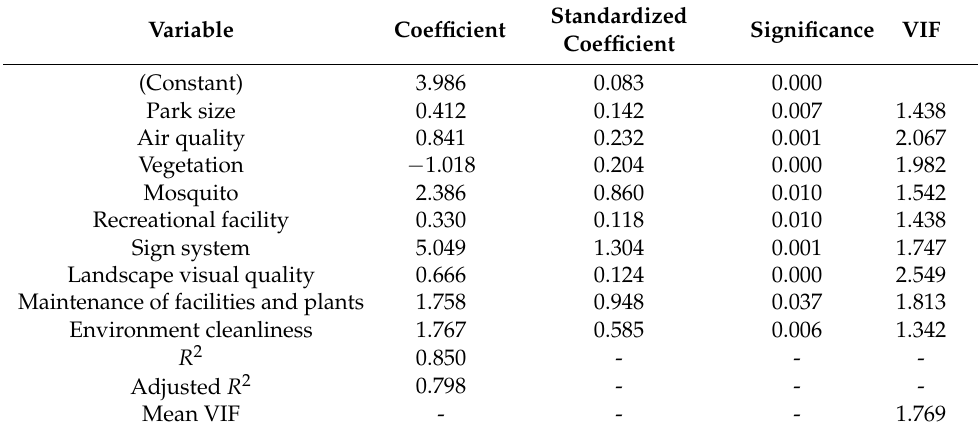
Table 3. The results from multiple linear regressions of people’s satisfaction with parks on predictors. Standardized Variable Coefficient Coefficient